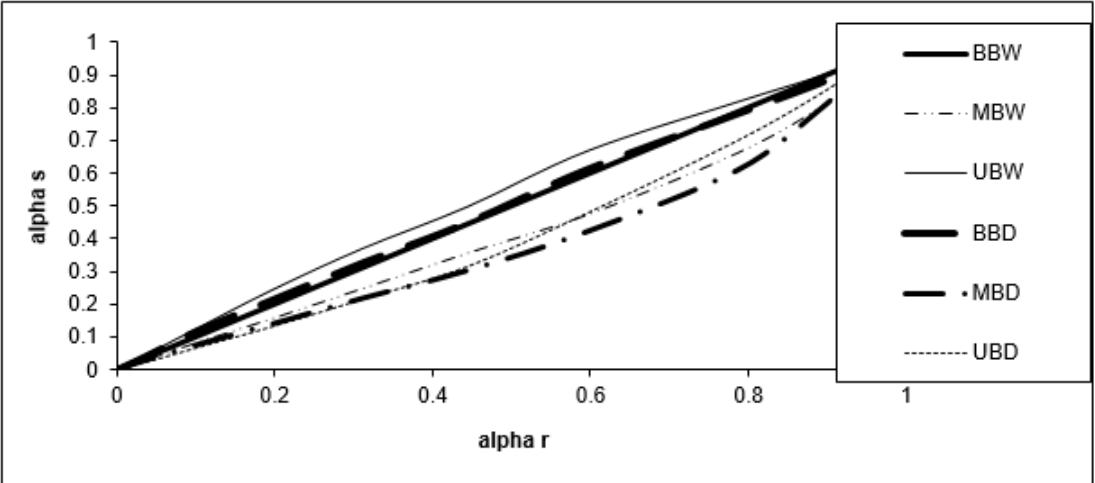
Figure 8. Alpha s–alpha r dependence of okra bast fibers.